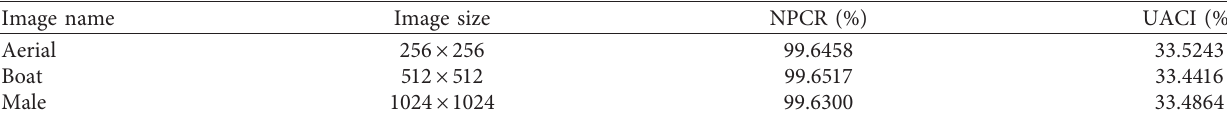
Table 8: NPCR and UACI results for cipher grayscale images.